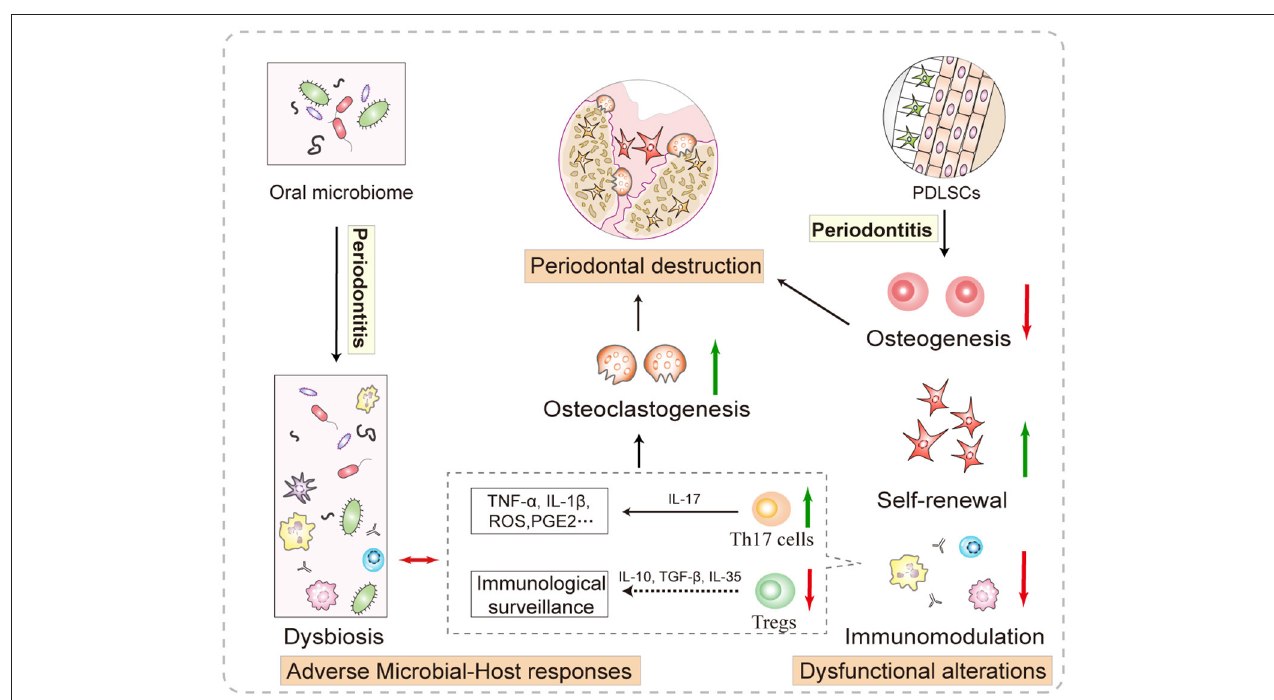
FIGURE 1 | Local factors that promote periodontal destruction. The adverse immunity and continuous stimulation of the dysbiotic microbiome reinforce each other and create a hostile microenvironment for stem cell function. More importantly, the compensatory and decompensatory responses of resident P-PDLSCs are involved in shaping the local microenvironment. Specifically, the increased proliferation of P-PDLSCs cannot offset osteogenesis disorder, which indirectly leads to bone homeostasis imbalance. In addition, abnormal P-PDLSC immunoregulation increases Th17 cell differentiation. These IL-17-releasing cells trigger massive production of inflammatory cytokines, such as TNF- α and IL-1 β , which promote osteoclastogenesis and bone loss, and the Treg-mediated dysregulation of immunological surveillance promotes the above inflammatory